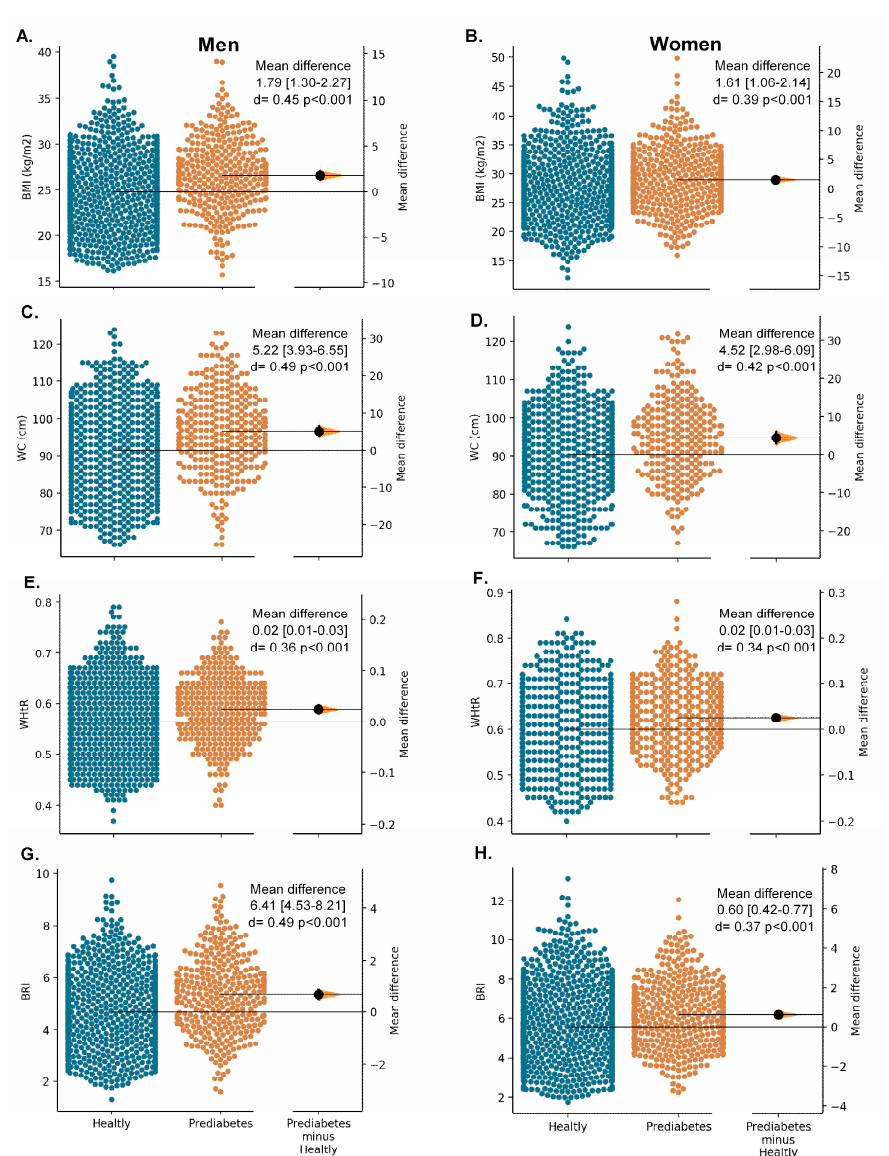
Figure 2. The Gardner–Altman plots for unadjusted surrogate obesity indices (BMI, WC, WHtR and BRI) according glycaemia status and sex.